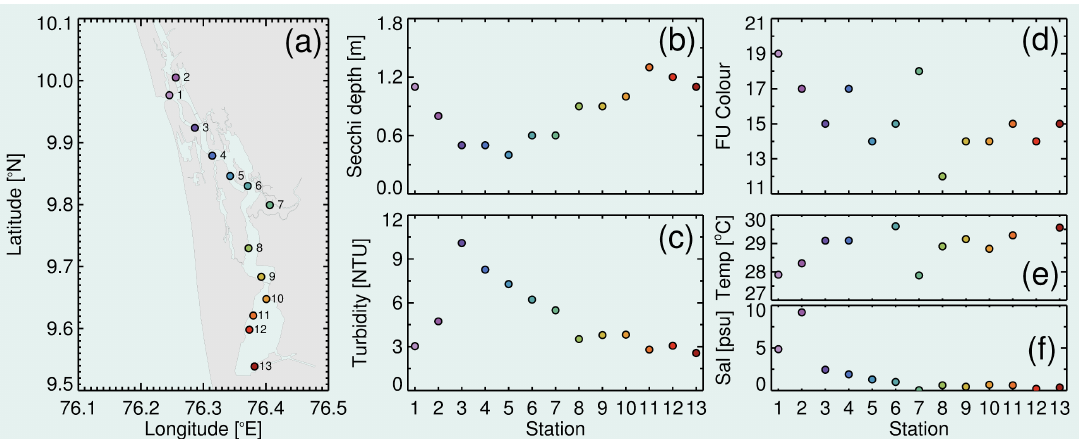
Figure 7. Deployment of the mini-Secchi disk in Vembanad lake on the 30th and 31st May 2018. ( a ) Stations sampled with the mini-Secchi disk and CTD rosette sampler equipped with a WET Labs ECO triplet. ( b ) Secchi depth readings using the mini-Secchi disk, ( c ) water turbidity at the surface (top 1m), and ( d ) Forel Ule colour readings using the mini-Secchi disk. ( e ) Surface (top 1m)